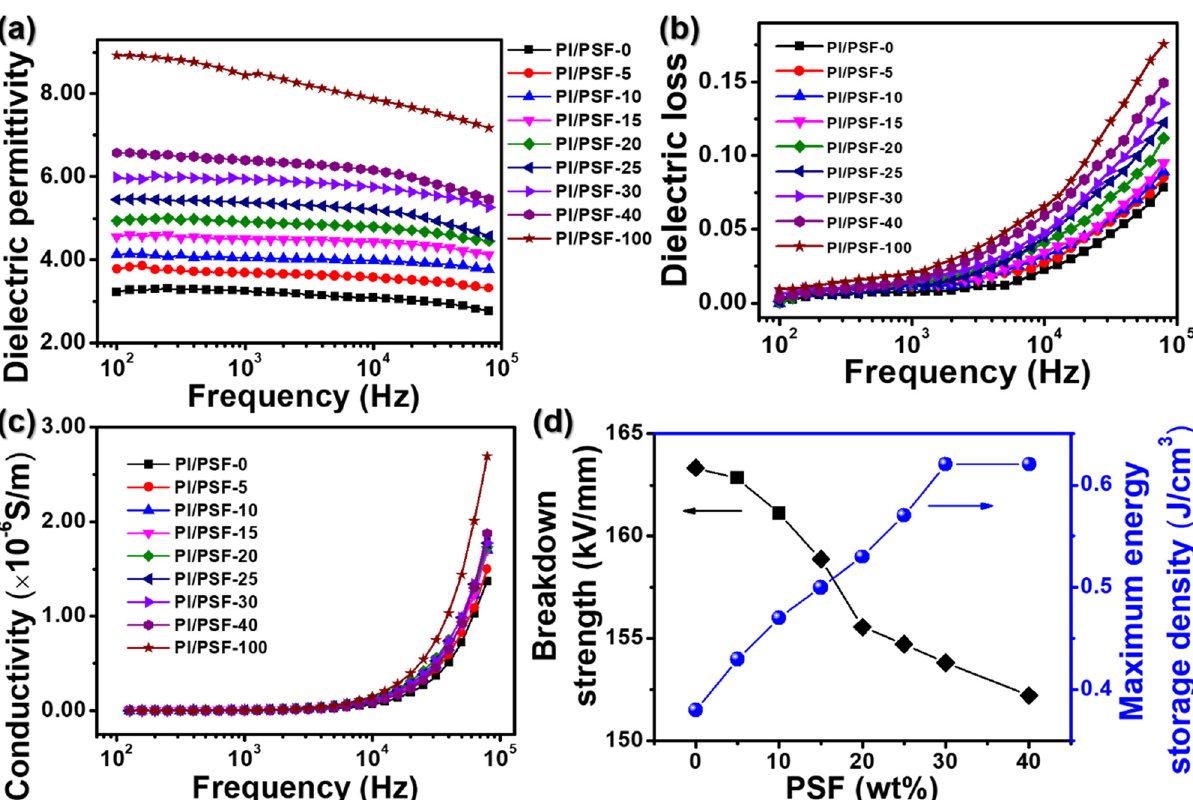
Figure 3: Frequency - dependent dielectric permittivity ( a ) , dielectric loss ( b ) , electrical conductivity ( c ) and the dielectric breakdown strength and maximum energy storage ( d ) of the PI/PSF - X composite fi